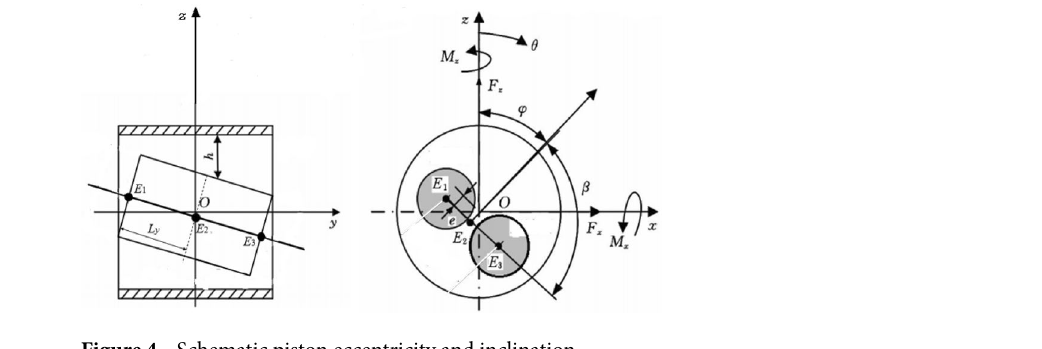
Figure 4. Schematic piston eccentricity and